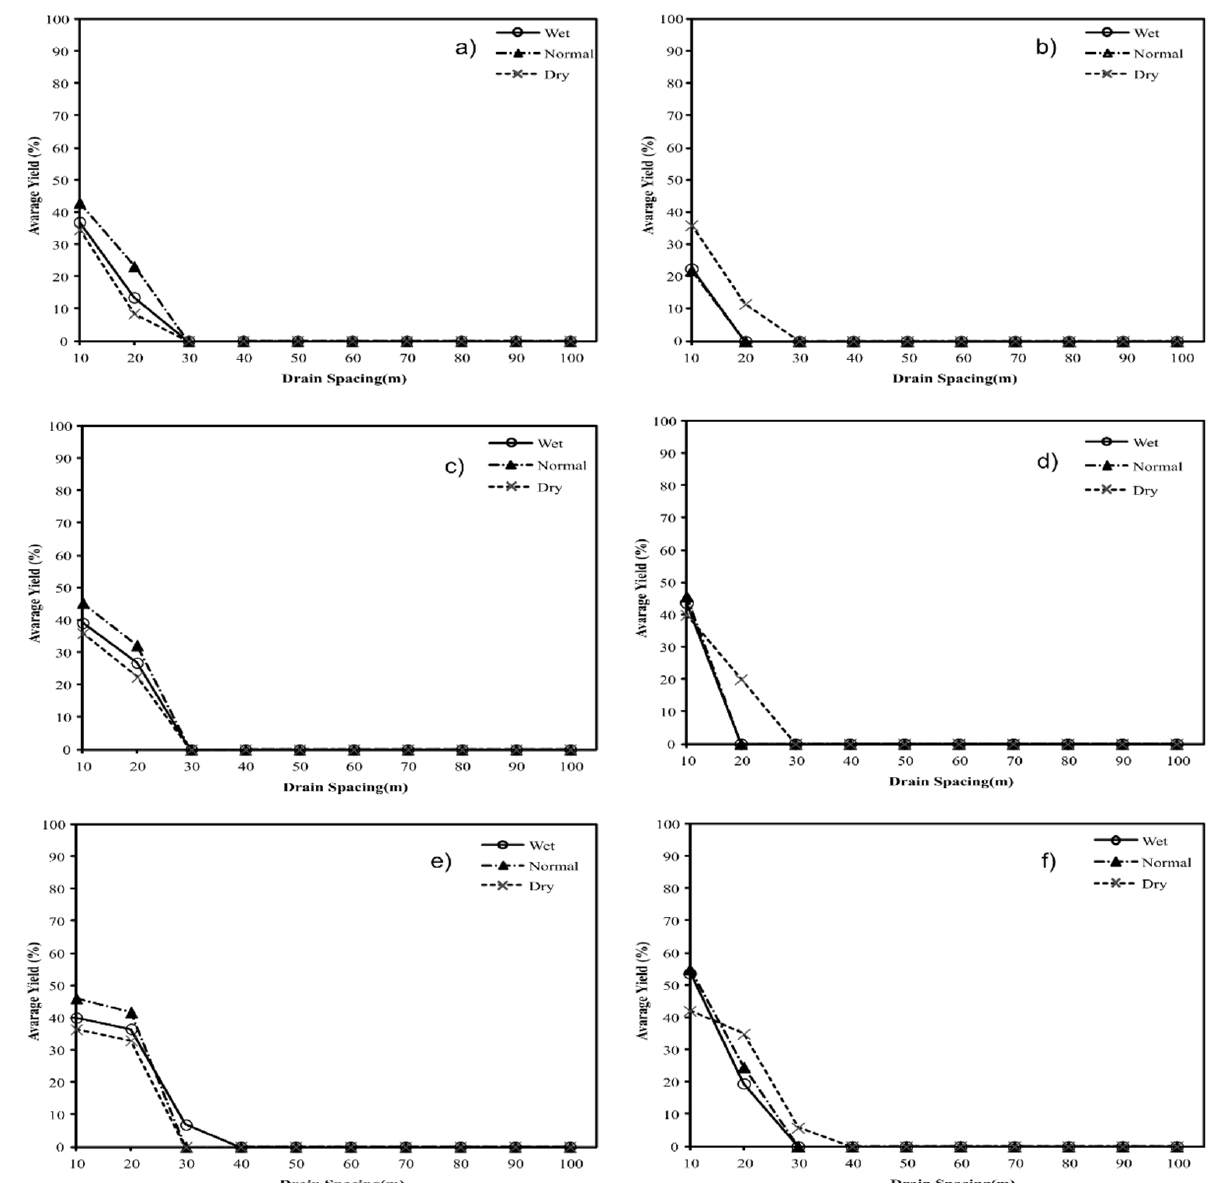
Figure 10. Yield of sugarcane (YT), for normal and dry and wet years for drain spaces varying from 10 to 100 m and drain depths of the 1.2 ( a , b ), 1.4 ( c , d ) and 1.6 ( e , f ) m in the Barinas ( a , c , e ) and Turen ( b , d , f ) weather stations.